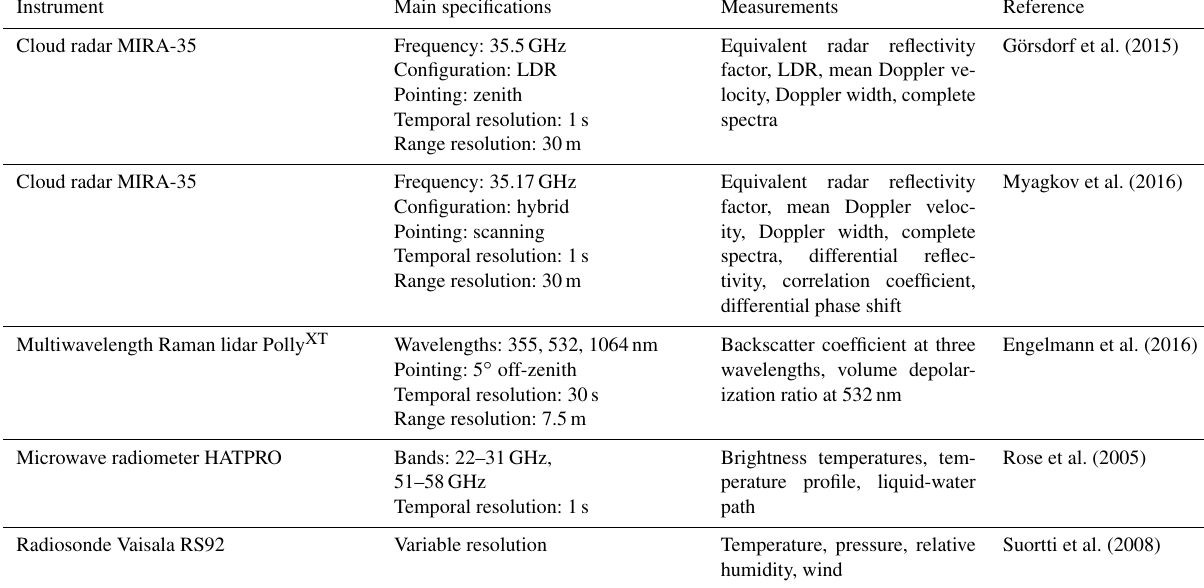
Table 1. The list of used